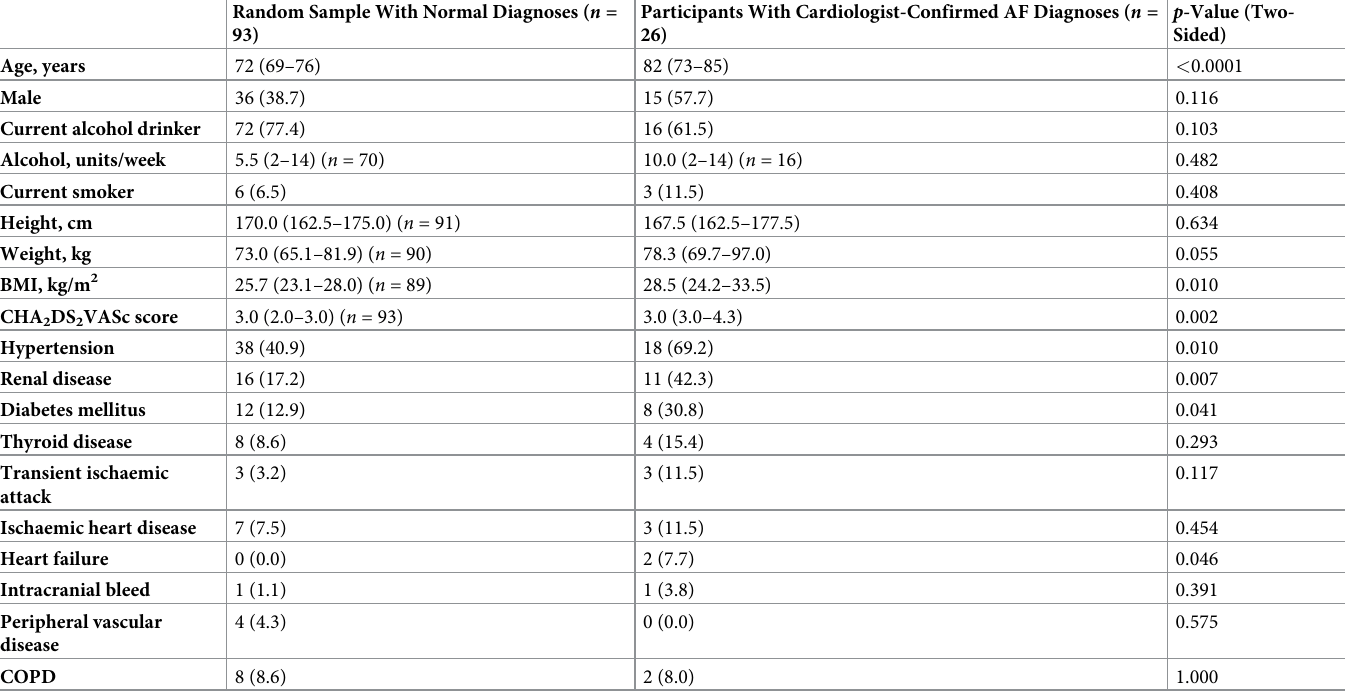
Table 3. A comparison of demographic characteristics between a random sample of participants with normal diagnoses ( n = 93) versus those with cardiologist-con- firmed AF diagnoses ( n = 26). Random Sample With Normal Diagnoses ( n = 93)